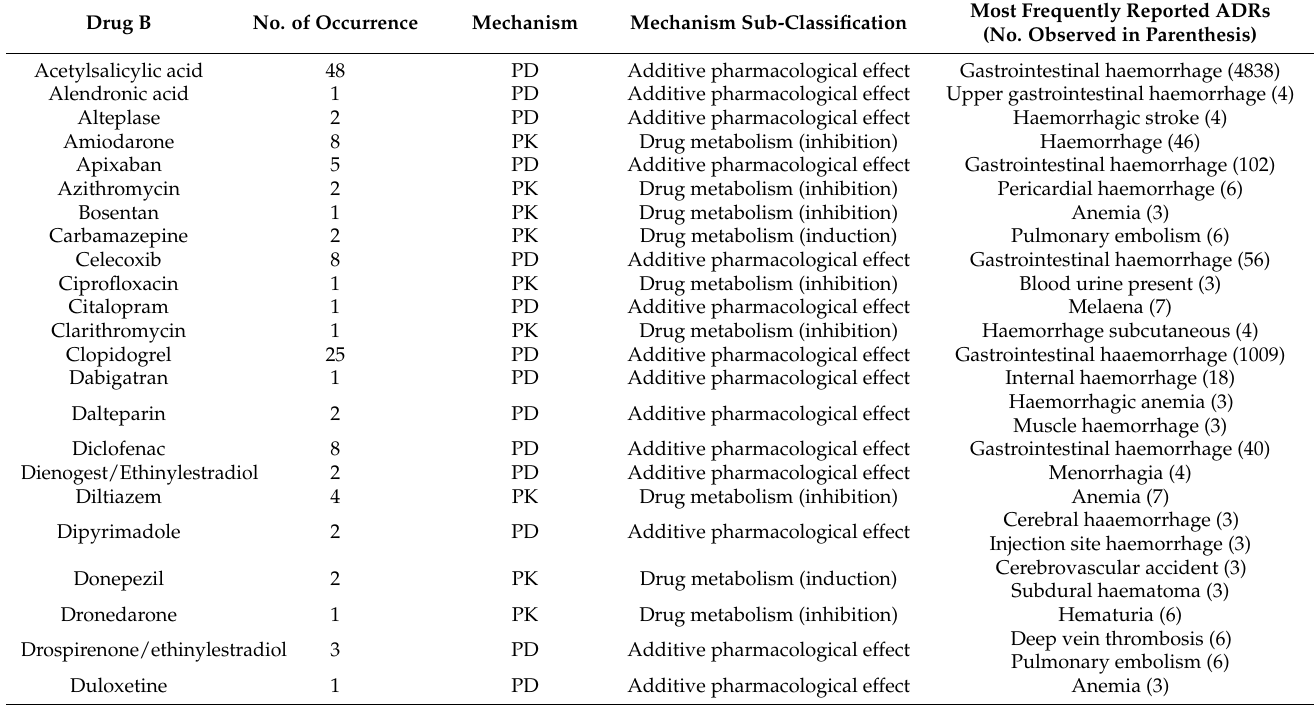
Table 3. Drug reported as interacting with rivaroxaban in VigiBase with interaction mechanism and most frequently reported adverse